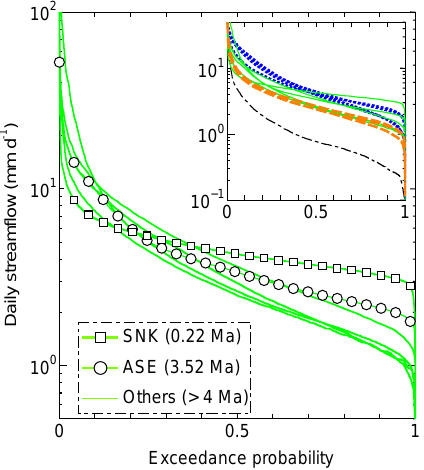
Figure 7. Flow–duration curves for the catchments, whose aridity index is in the range between 0.35 and 0.45. Inset of this figure illustrates flow–duration curves for all study catchments. Each col- ored line represents data from a certain range in aridity index (key to line colors is as follows: blue: PE /P < 0 . 35; green: 0 . 35 < PE /P < 0 . 45; orange: 0 . 45 < PE /P < 0 . 65; and black: PE /P > 0 . 65).